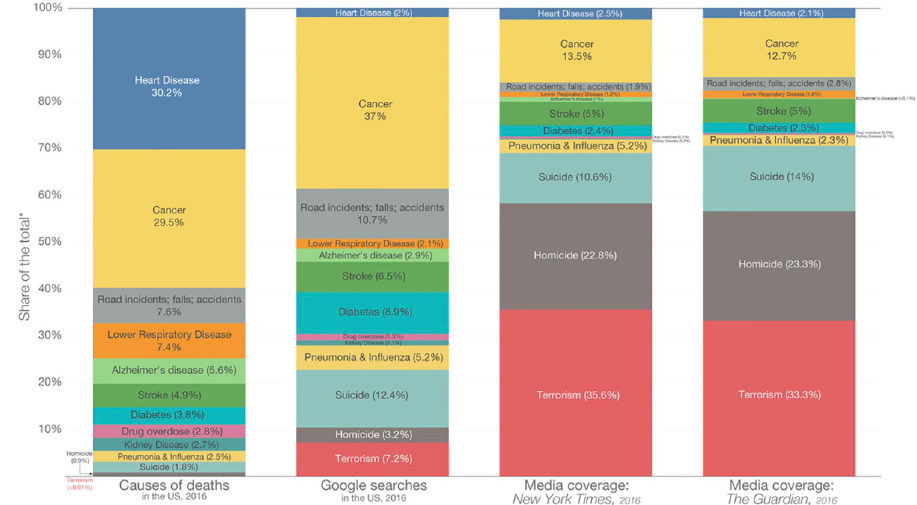
Fig 1. What Americans die from, what they search on Google and what the media reports on. (source https:// ourworldindata.org/does-the-news-reflect-what-we-die-from). Permission under the Creative Commons CC-BY